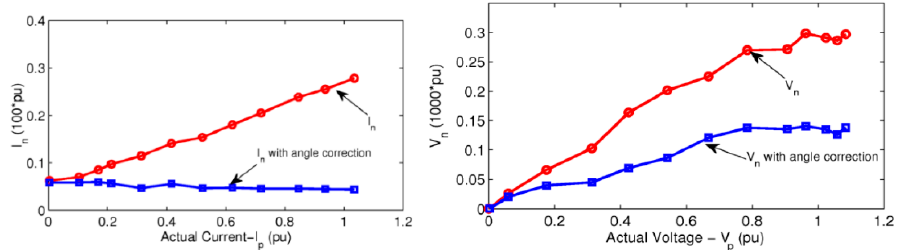
Figure 9. The magnitude of negative sequence components before and after offset angle correction, ( left ) for current and ( right ) for voltage.